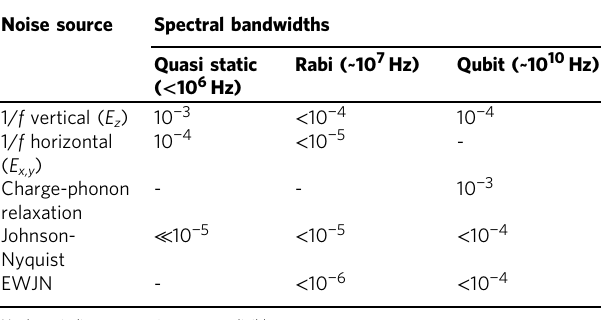
Table 1 Error rates of x ( y )-gates from different